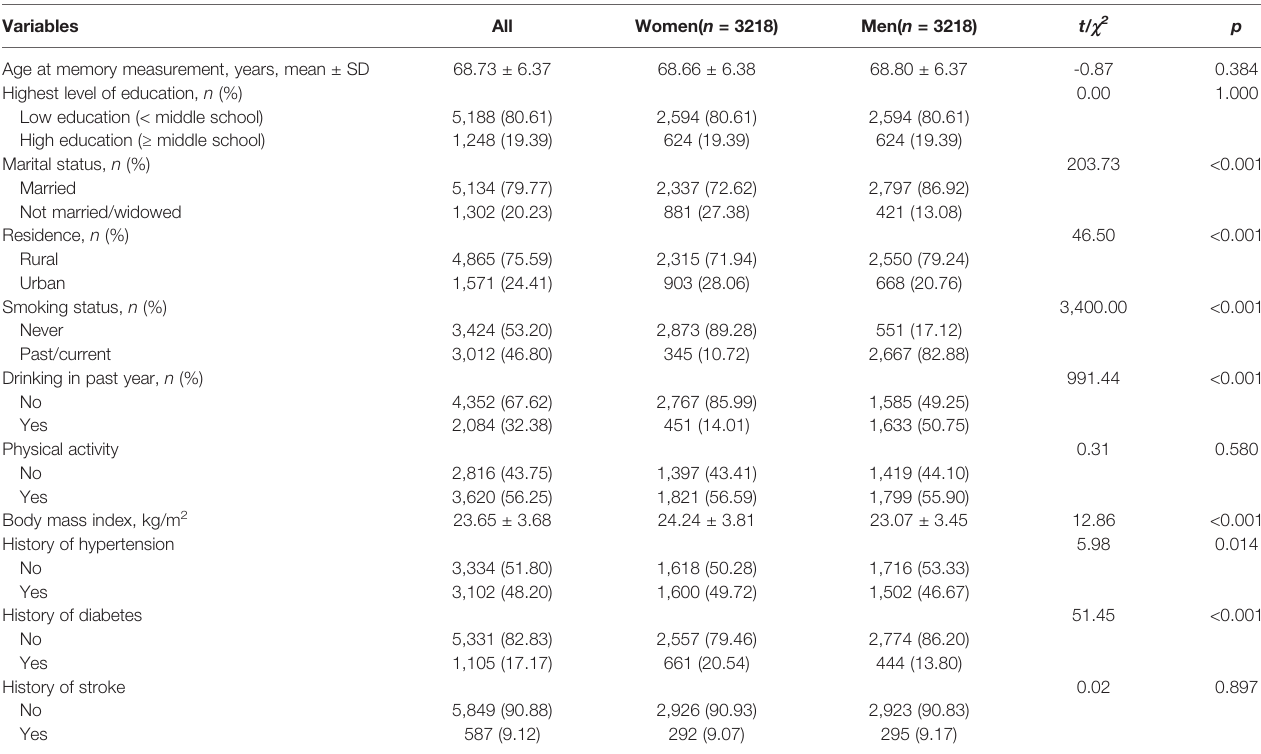
TABLE 1 | Characteristics of the study population ( n =